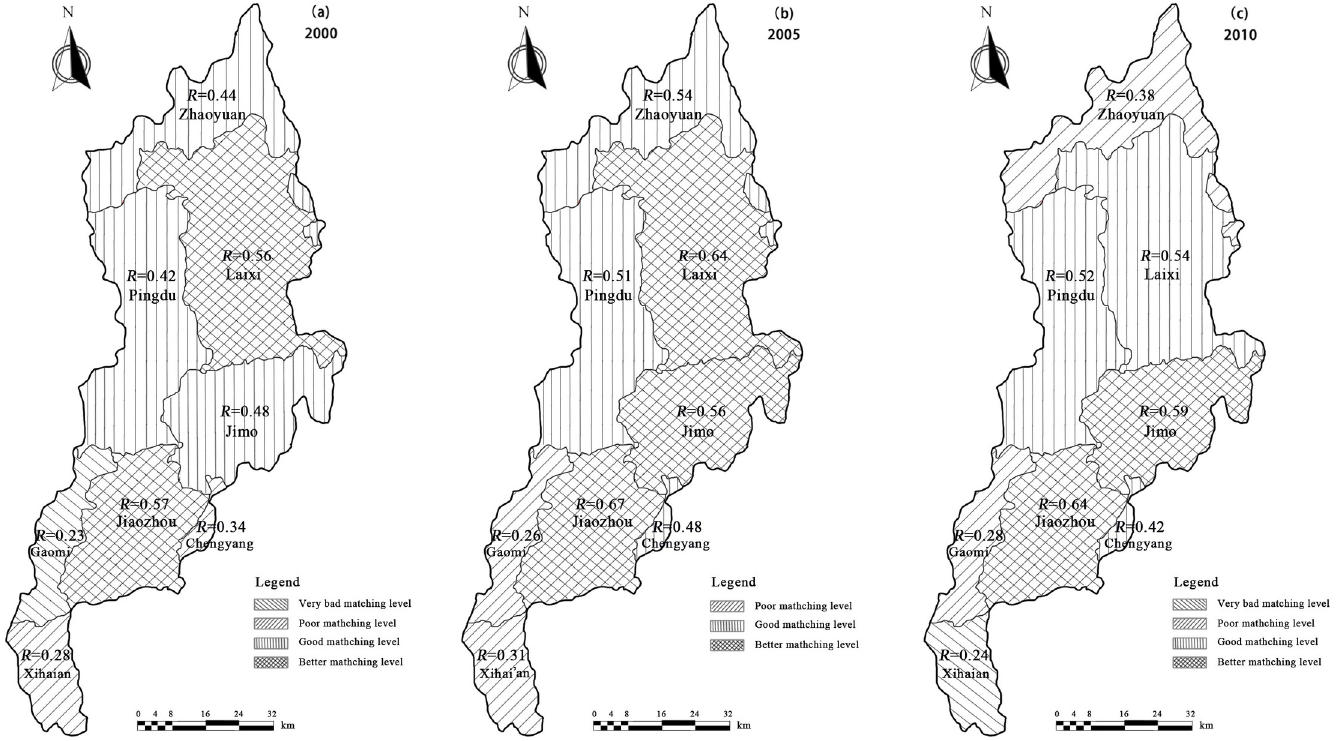
Fig 3. The matching levels of different space districts in different